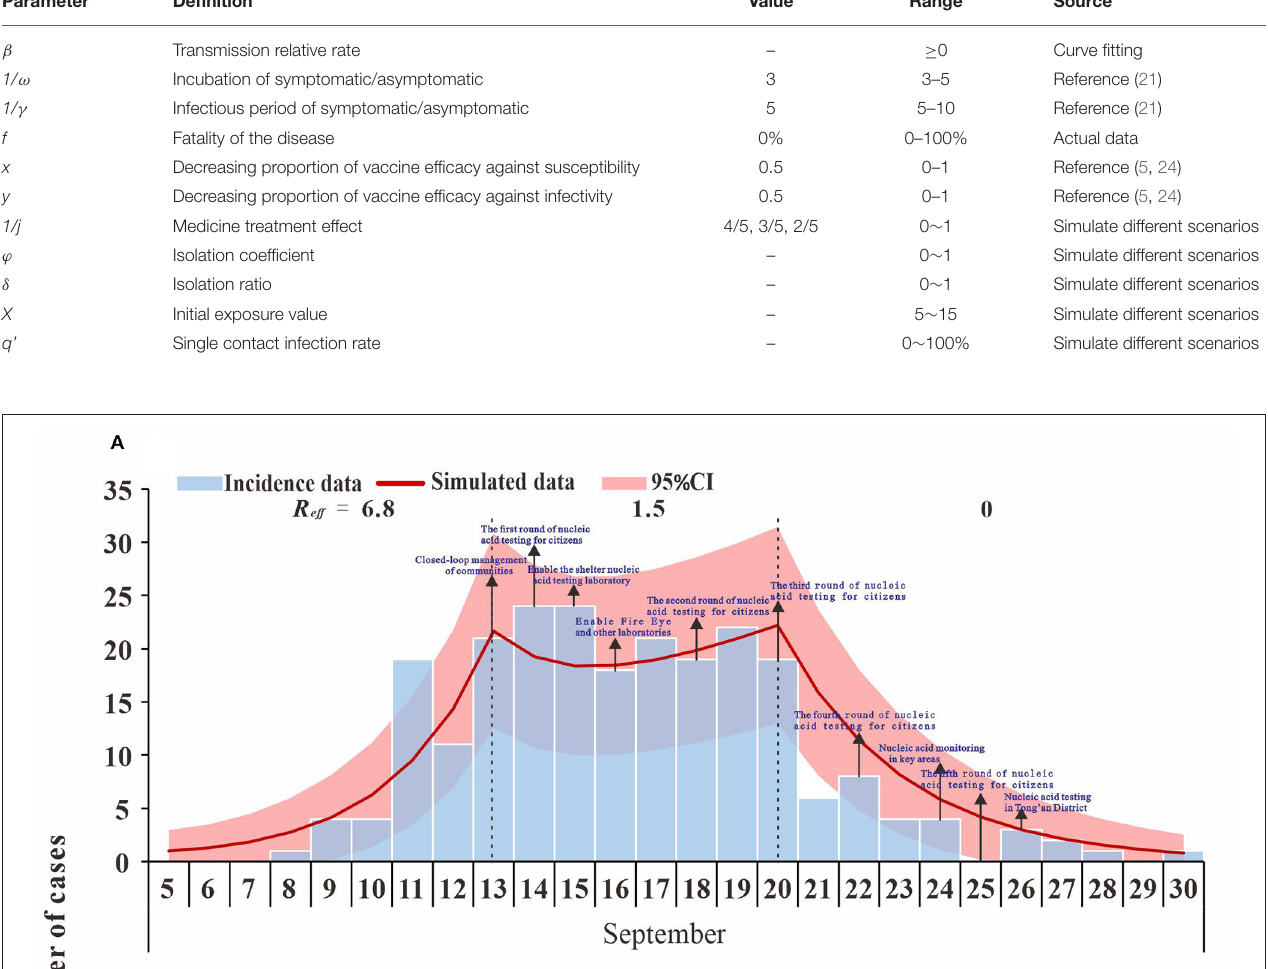
TABLE 3 | The definition and values of parameters in the SEIR model of COVID-19 in Xiamen City, China (2021). Parameter